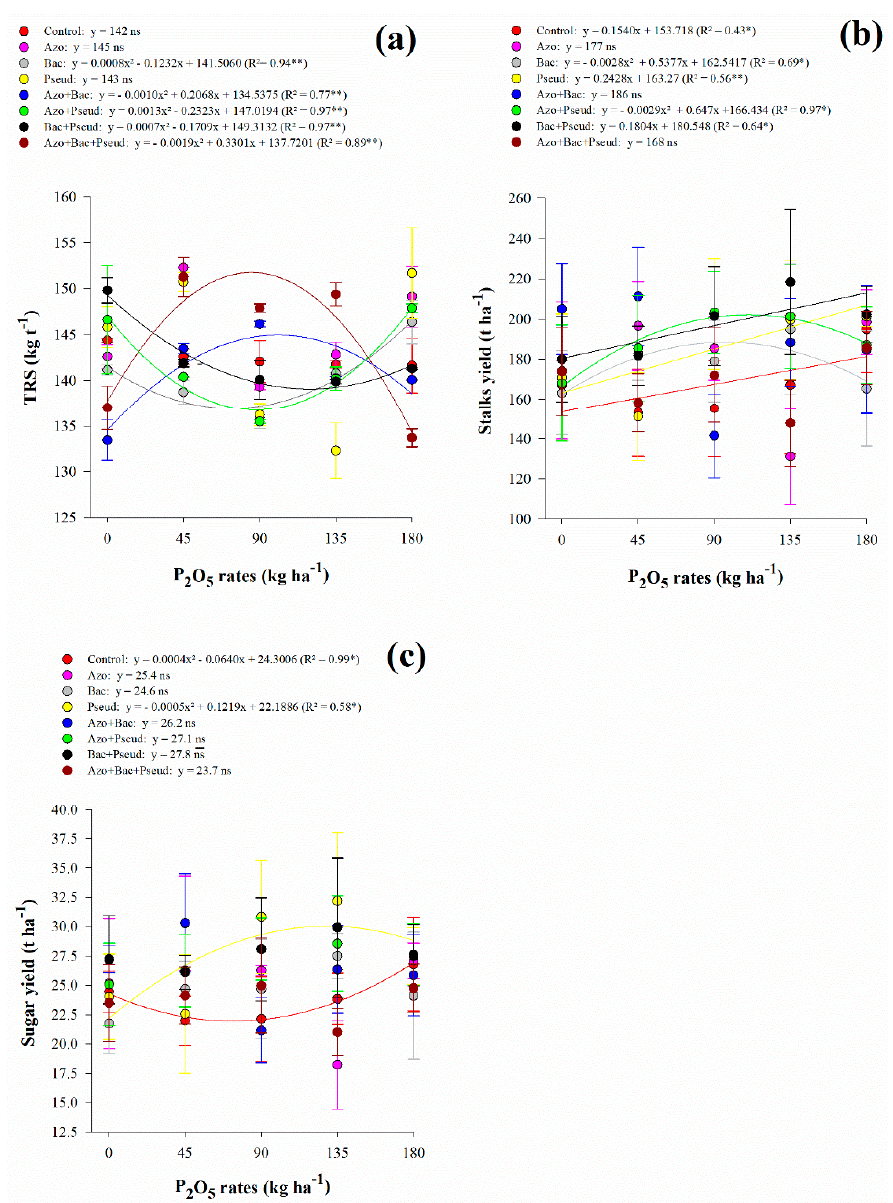
Figure 3. Interaction between P 2 O 5 rates and inoculations in total recoverable sugars (TRS) ( a ), stalks yield (STY) ( b ) and sugar yield (SUY) ( c ). Error bars indicate the standard deviation of the mean ( n = 3). **, * and ns: significant at 1% at p < 0.01, 5% at p < 0.05 and p > 0.01 and not significant,